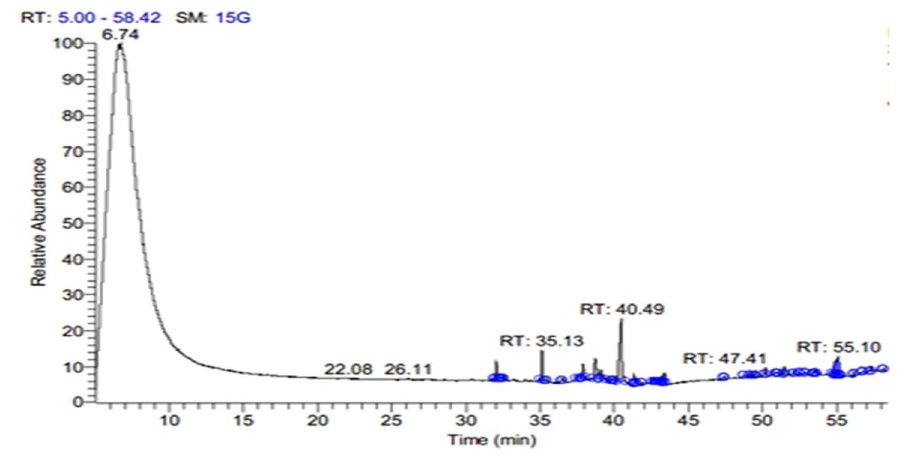
Figure 3. GC-MS Chromatogram of S. costus extract by SFE at a pressure of 48 MPa (E48).